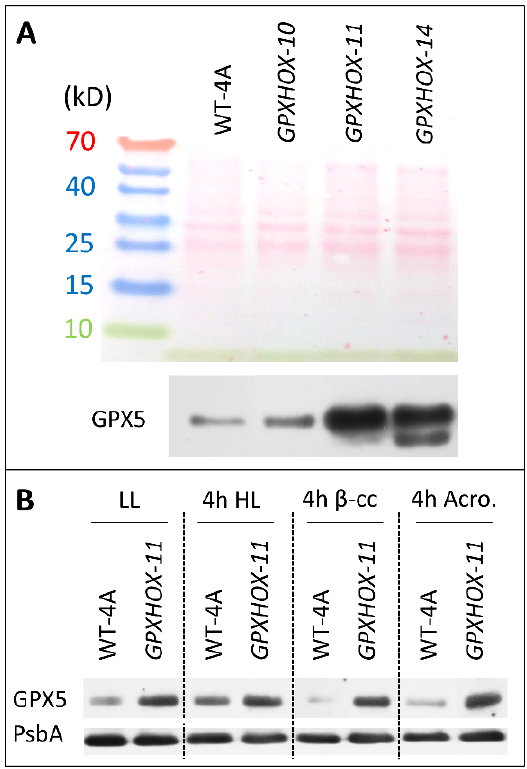
Figure 2. Protein levels of GPX5 in WT-4A and GPX5 -overexpressor ( GPXHOX) mutants under LL and in response to HL, β -cyclocitral and acrolein. ( A ) Three GPXHOX lines and WT-4A were analysed for GPX5 protein levels under LL. Shown above is the Ponceau-stained membrane for loading control. ( B ) The effect of LL, 4 h with HL, and 4 h with 600 ppm of β -cyclocitral ( β -cc) or with 600 ppm of acrolein (4 h Acro.) under LL, on GPX5 levels. The D1 reaction centre of photosystem II (PsbA) was used for loading control.